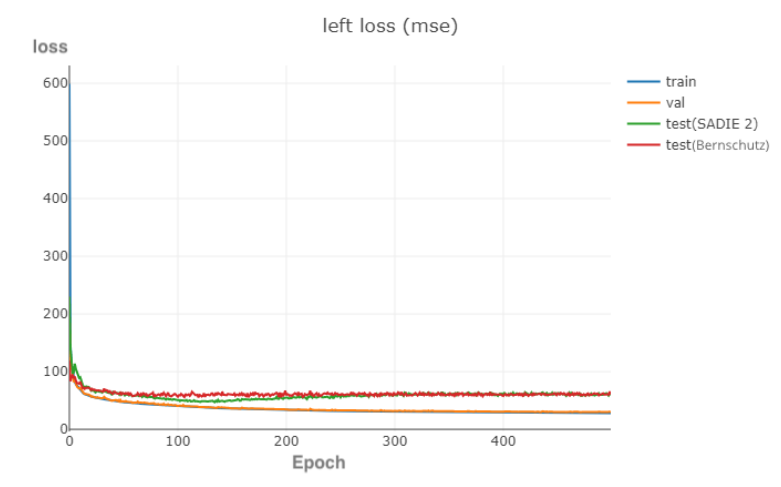
Figure 7. Left MSE during training (blue: training loss, orange: validation loss, green: hold out test data Subject 20 from SADIE II, red: Bernschutz KU100), which shows that the model over-fit the training data.